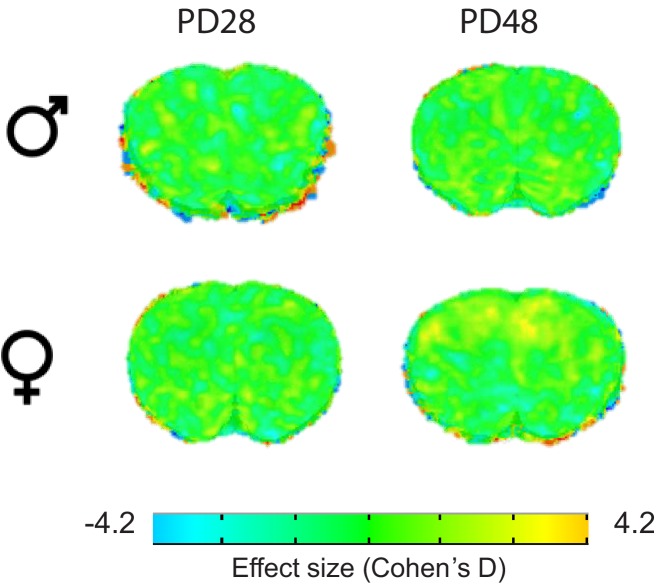
Effect size maps for cortical sections comparing CON to ELS in males and females at PD28 or PD48.Effect sizes in the regions highlighted in Figure 5 range from 1.4 to 2.8. Full set of effect size maps generated are available on Dryad https://datadryad.org/stash/share/5u-rMFOwFrQvAHLThMjzn-rTA7Ne3HDELZbvjfTR0Ks.